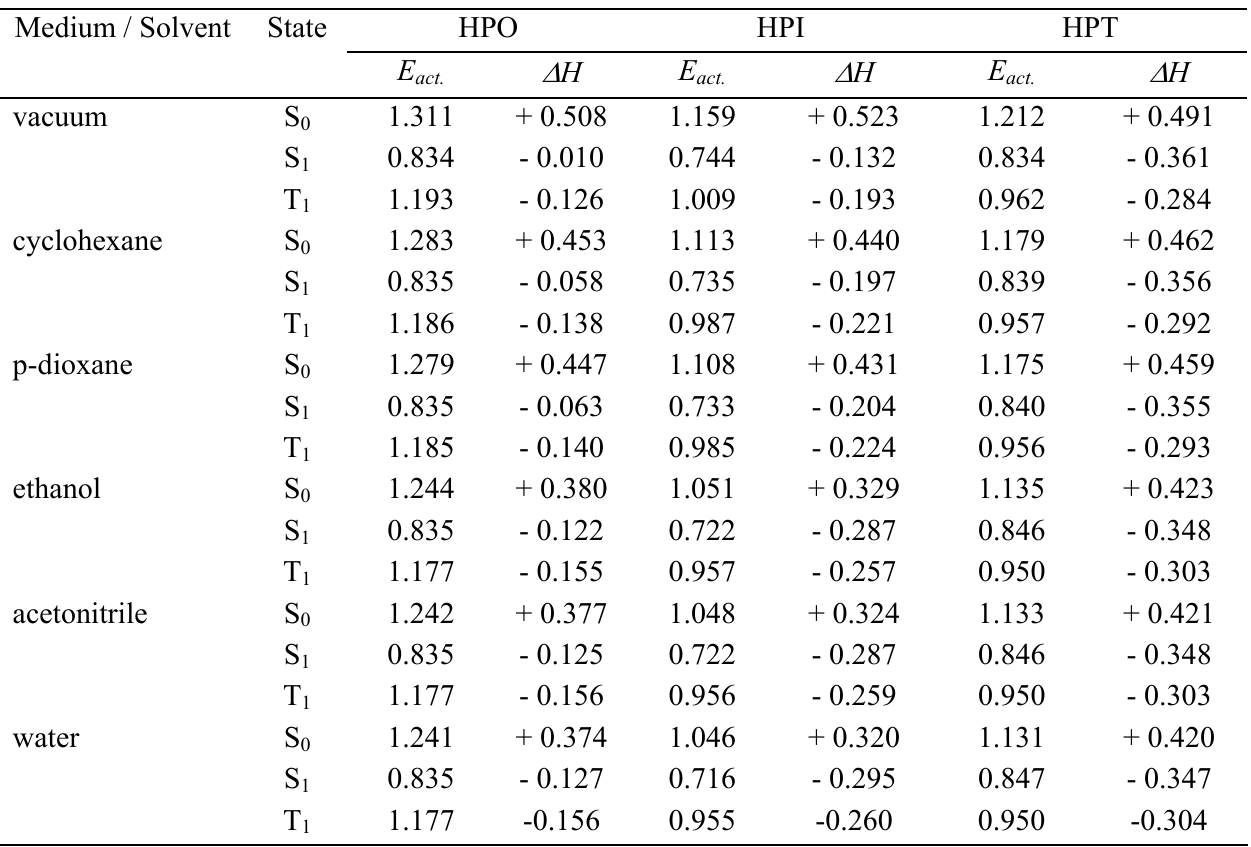
in eV) and reaction enthalpies ( ∆ H in eV) for the act , S and T states. 0 1 1